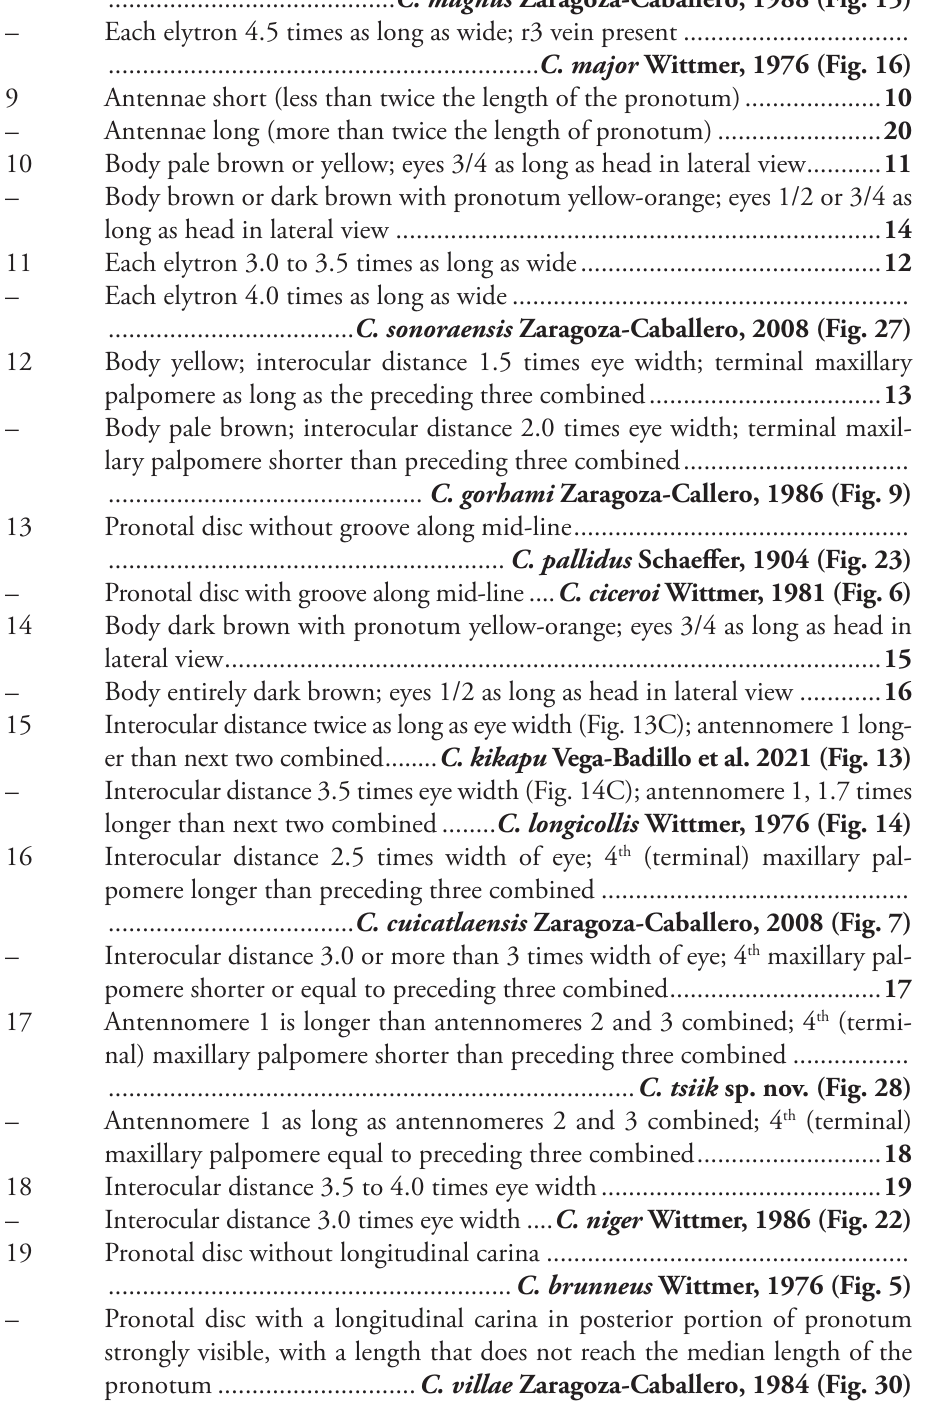
– Pronotal disc with a longitudinal carina in posterior portion of pronotum strongly visible, with a length that does not reach the median length of